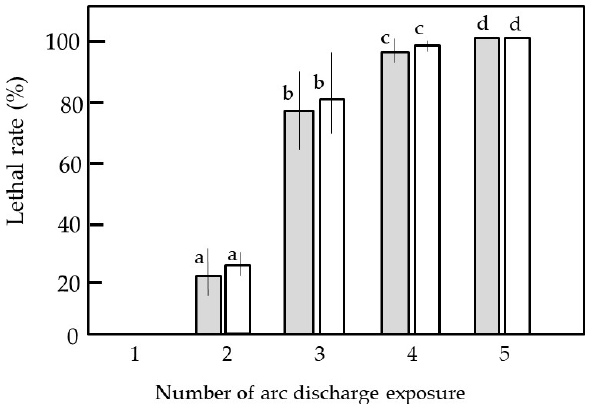
Figure 6. The mortality of the houseflies that were transferred onto the grounded metal net (G-MN) facing the negatively charged metal net (NC-MN) of the arc-discharge exposer (ADE). Anesthetized male (gray) and female (open column) houseflies were individually transferred onto the G-MN and subjected to an arc discharge from the NC-MN. After 1–5 arc-discharge exposures, their survival was examined. We used 20 insects of each sex. Means ± standard deviation were calculated from five experimental replicates. Different letters (a–d) on each column indicate significant differences ( p < 0.05) according to Tukey’s test.